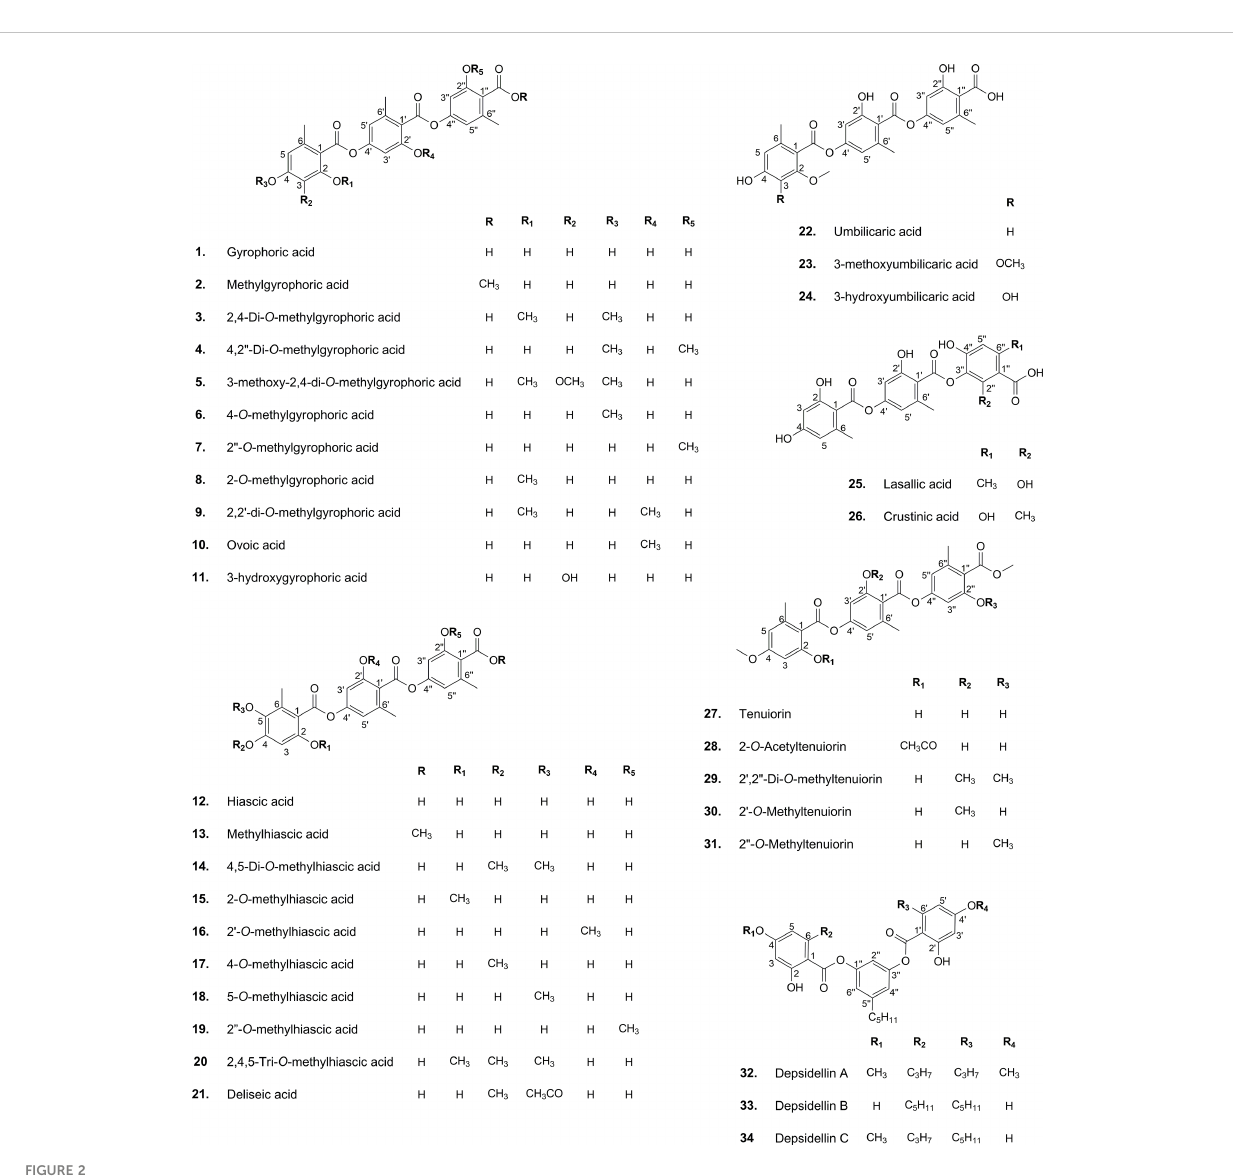
FIGURE 2 Chemical structure of common lichenic tridepsides and their